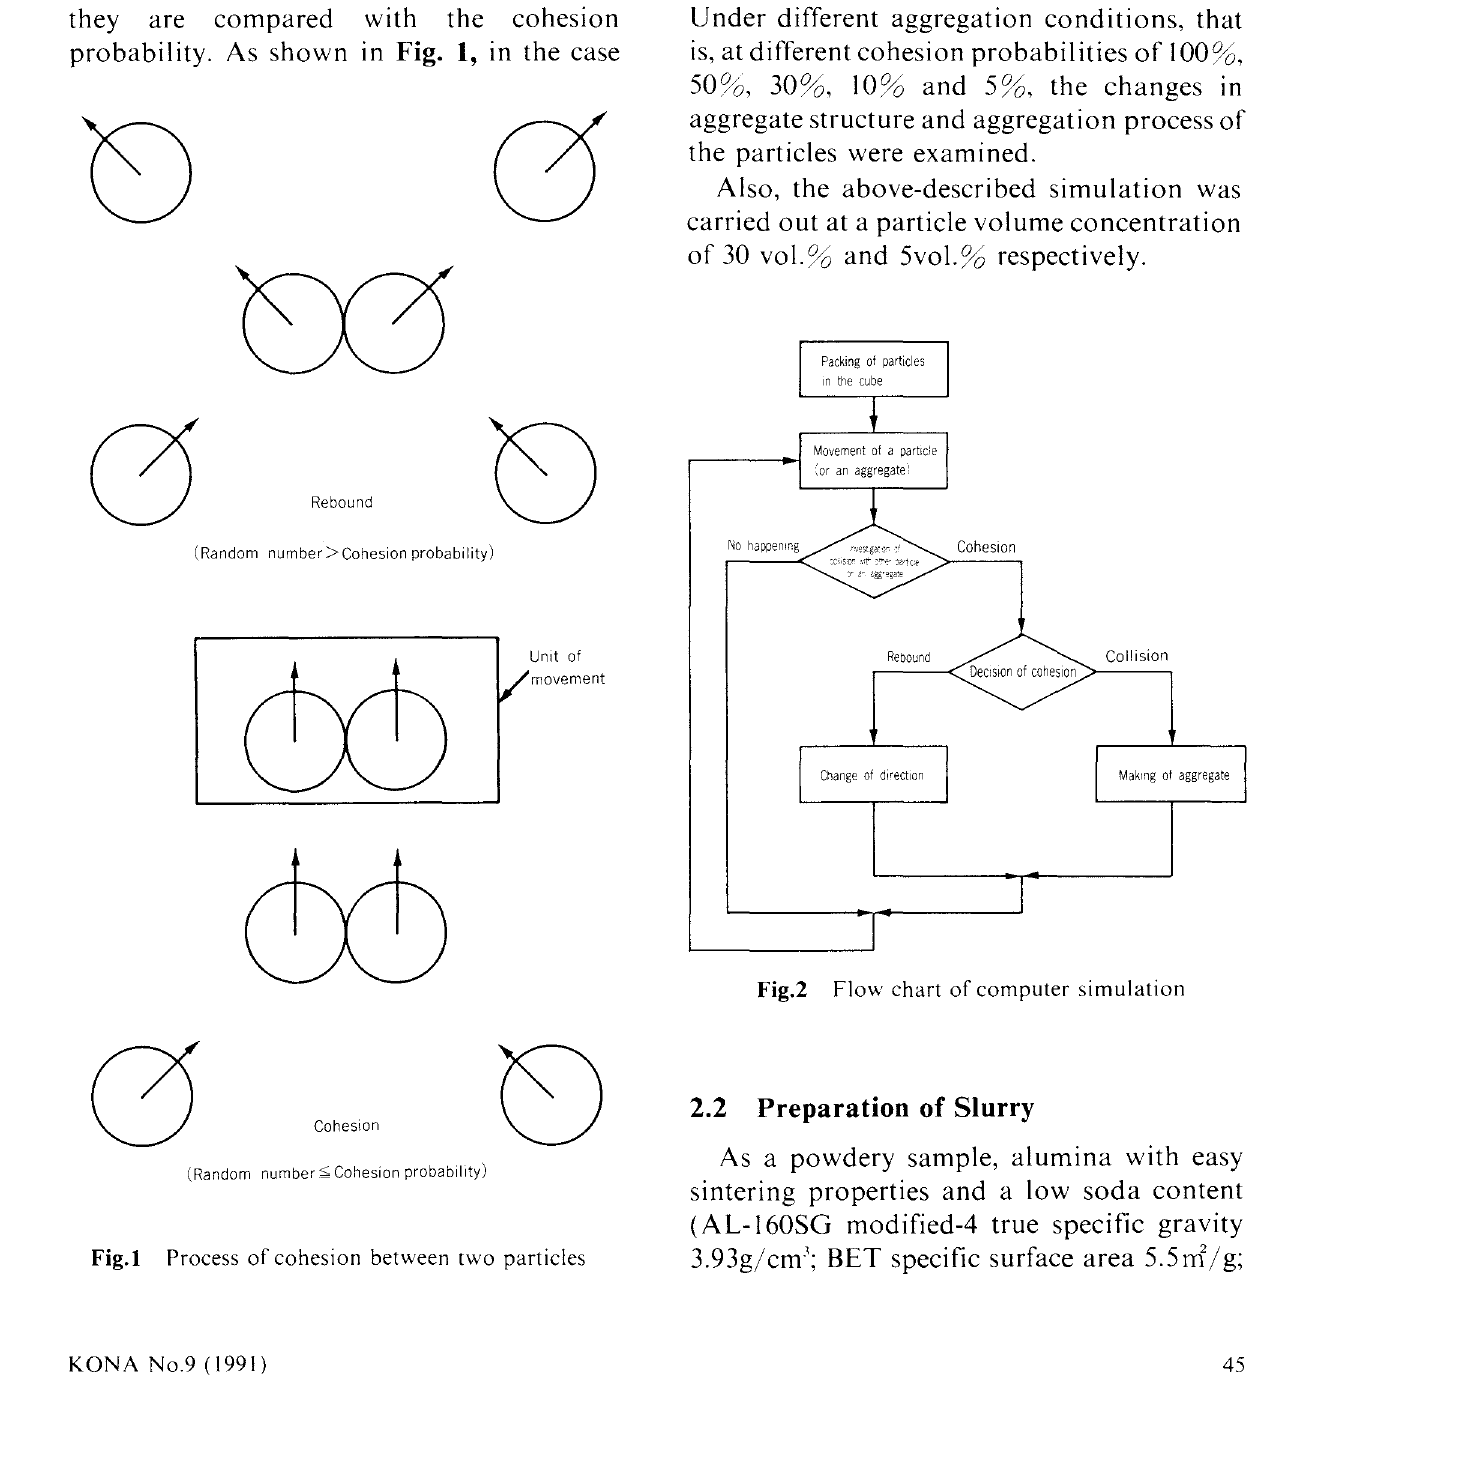
Fig. I Process of cohesion between two particles